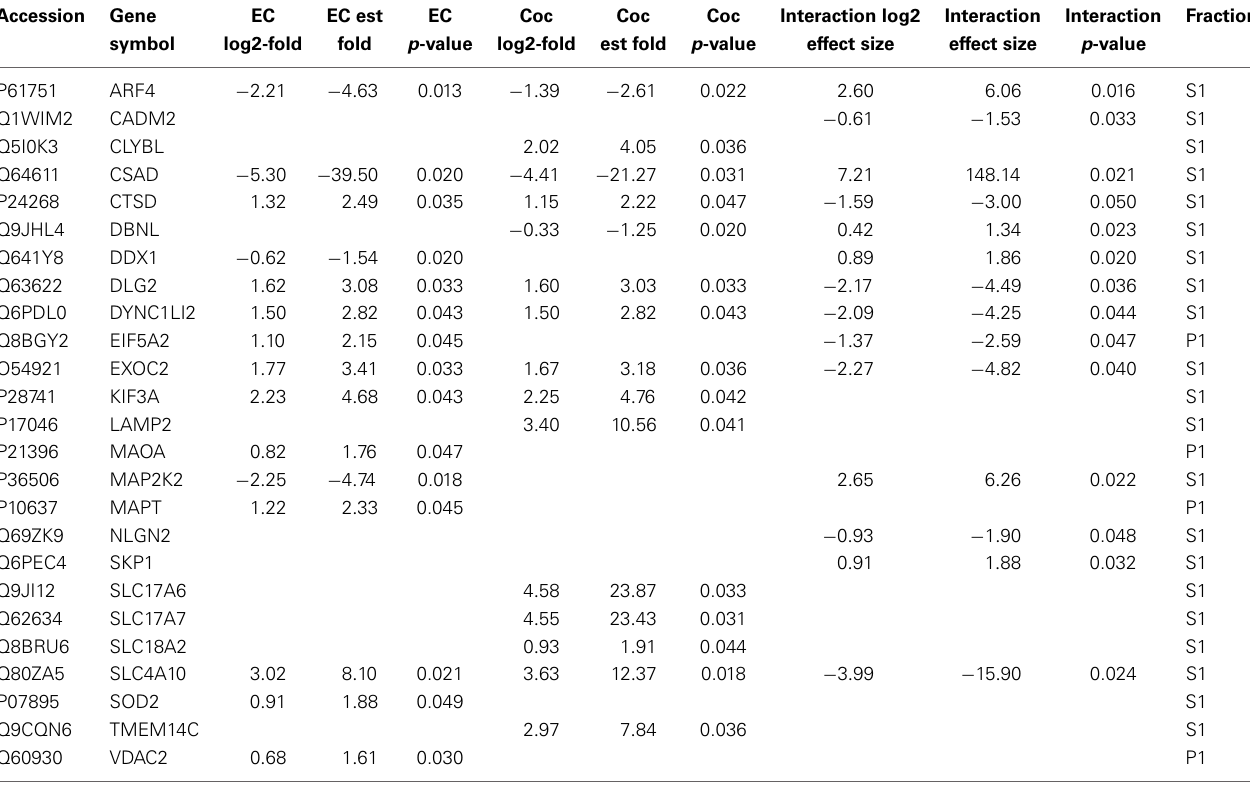
Table 1 | A selection of significantly changed proteins ( p < 0 . 05; fold change > 1.5) for cocaine main effect, environmental enrichment main effect and cocaine X enrichment